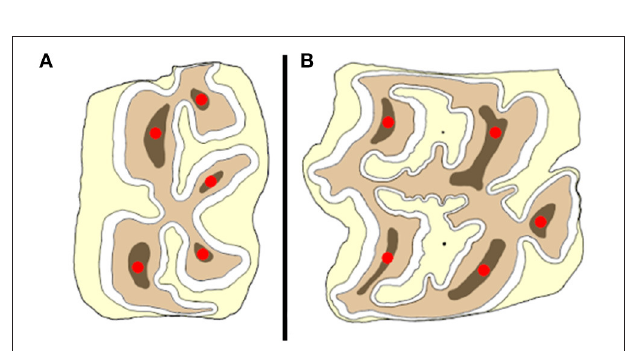
FIGURE 1 | Schematic illustration of the placement of the tip of the compression device (red dots) on a mandibular (A) and maxillary (B) cheek tooth at different anatomical